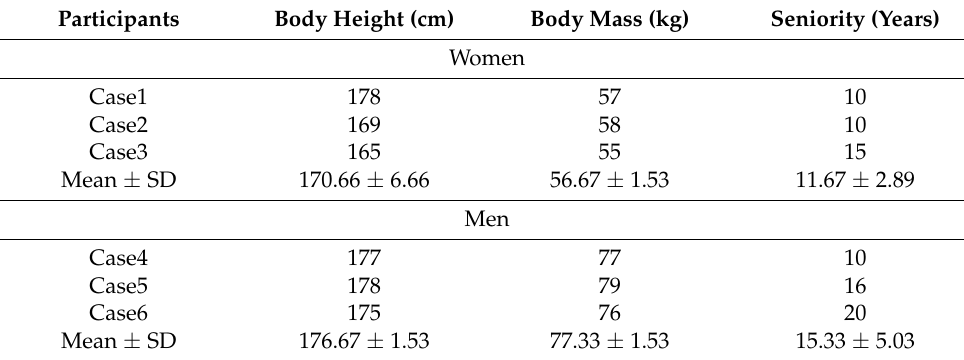
Table 1. Characteristics of the